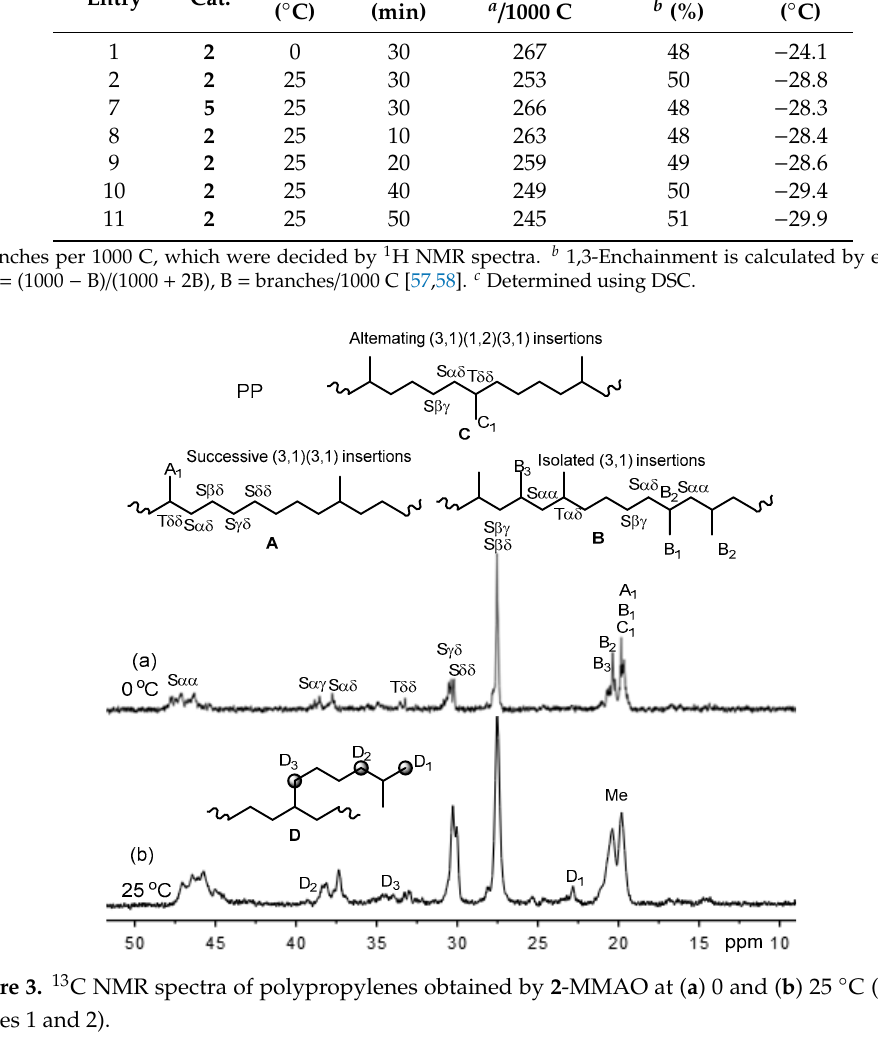
Figure 3. 13 C NMR spectra of polypropylenes obtained by 2 -MMAO at ( a ) 0 and ( b ) 25 °C (Table 1, entries 1 and 2).